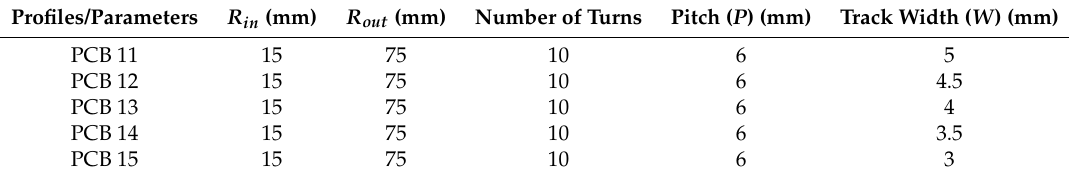
Table 4. Dimensional parameters of ten-turn PCB